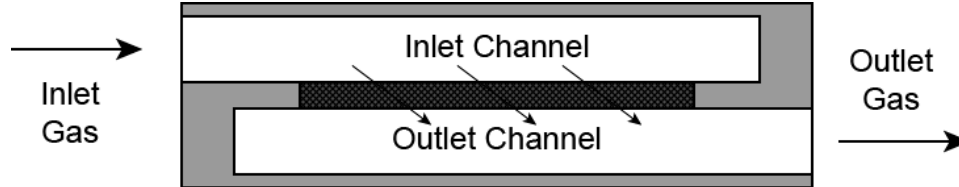
Figure 1. Filtration mechanism of DPF.